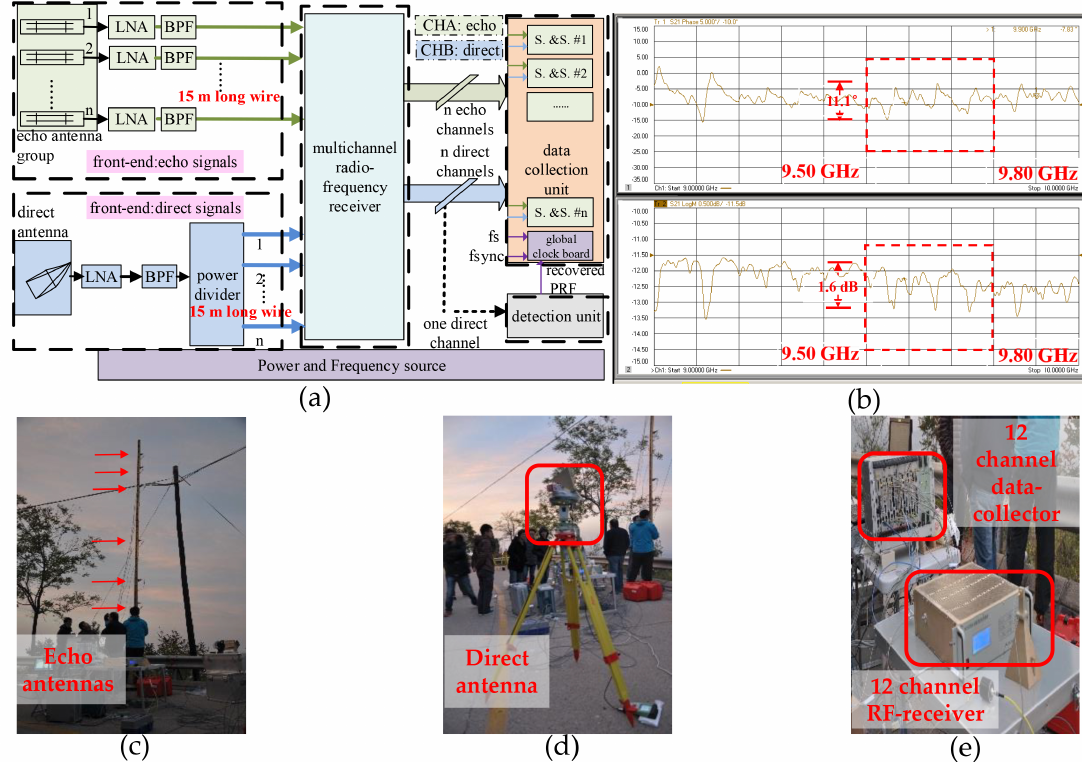
Figure 2. The system structure and the experimental scene. ( a ) The multichannel BiSAR stationary receiver system; ( b ) the example of the non-ideal factors: the phase-frequency response (linear delay removed) and amplitude-frequency response of one of the 15 m-long cables (9.50–9.80 GHz); ( c ) echo antennas; ( d ) the direct antenna; ( e ) the twelve-channel data collector and RF